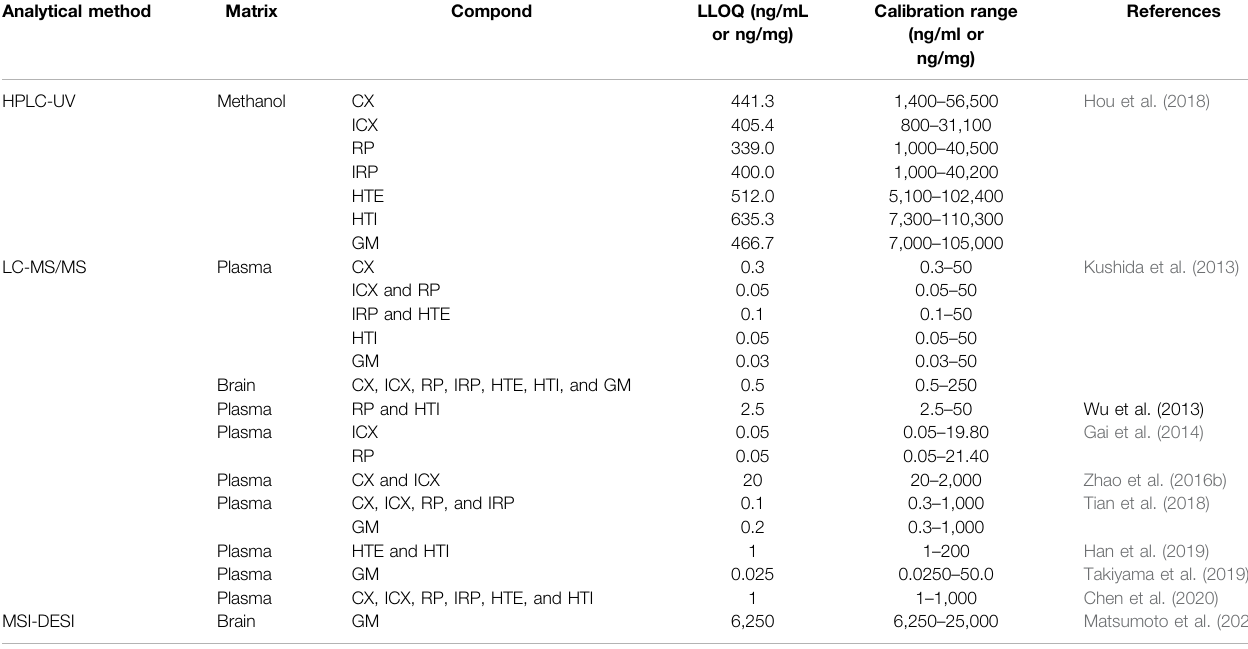
TABLE 1 | Lower limit of quanti fi cation and calibration range of UH alkaloids in various analytical methods. Analytical